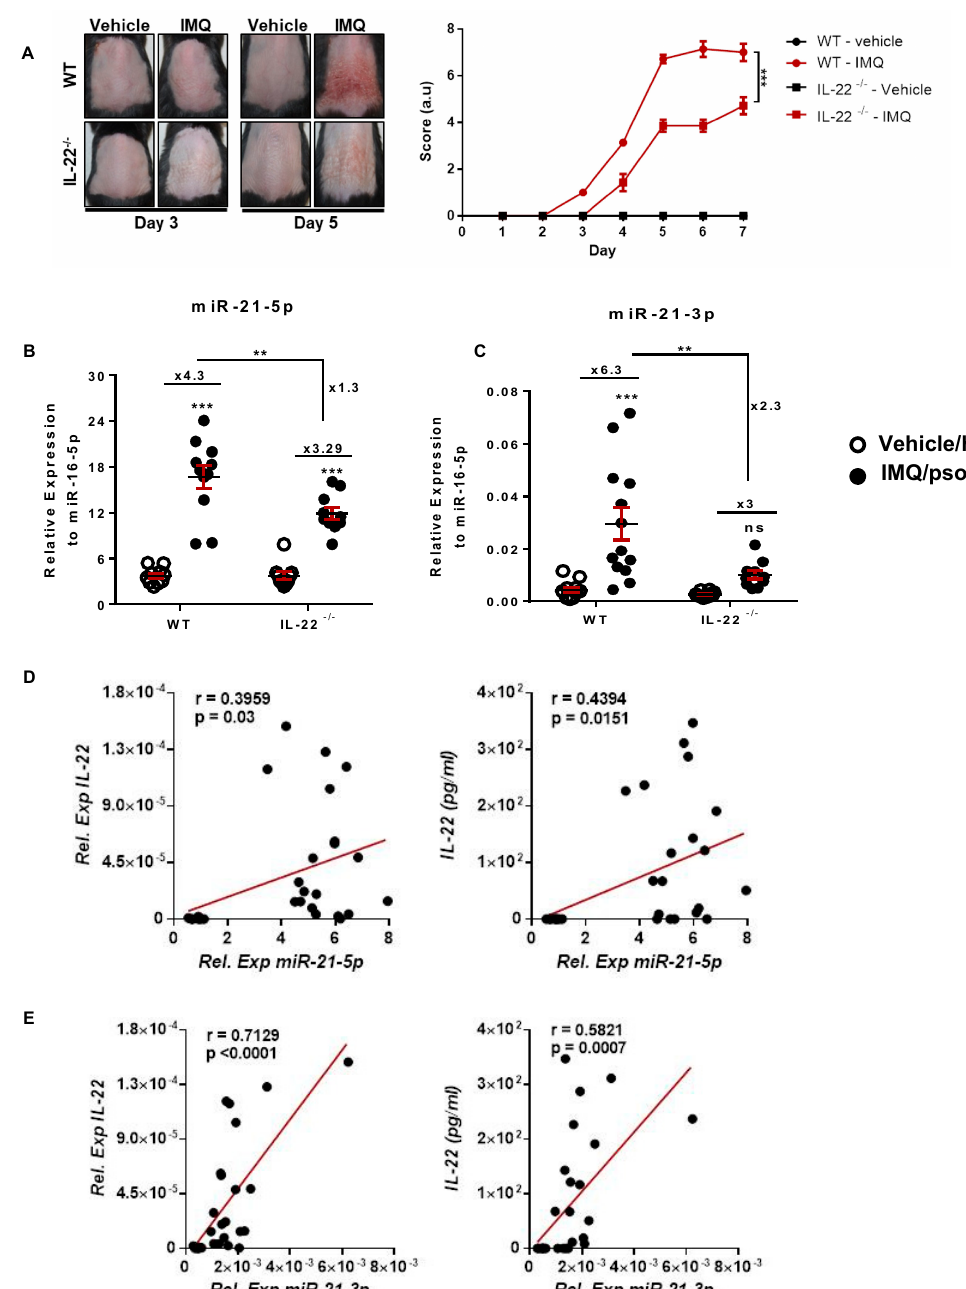
Figure 1. miR-21 (5p and 3p) expression patterns during psoriasis development. IMQ was applied daily for 6 consecutive days on the shaved backs of C57BL/6 wild-type (WT) and IL-22-knockout mice (IL-22 − / − ) . Pathogenesis was studied from day 1 to day 7. ( A ) Pictures of mice representing skin lesions throughout the development of psoriasis skin lesions (left), cumulative score representations (a.u.) of erythema and scaling, on the back skin, scored daily on a scale from 0 (absence of severity) to 4 (highest severity) (right). ( B , C ) RT-qPCR quantification of the relative expression of miR-21-5p- or miR-21-3p-to-miR-16-5p levels in lesional skin of mice treated with IMQ. ( D ) Pearson correlations established in 30 mice comparing the relative expression of miR-21-5p and IL-22 relative expression or IL-22 concentration (pg/mL) from skin protein lysates, assayed by ELISA. ( E ) Pearson correlations established in 30 mice comparing the relative expression of miR-21-3p and IL-22 relative expression or IL-22 concentration (pg/mL) from skin protein lysates, assayed by ELISA. Data information: results are presented as mean values ± SEM. Data are representative of two independent experiments with five mice per group. The statistical comparisons between groups were performed using the two-tailed Student t -test: ** p < 0.01, *** p <